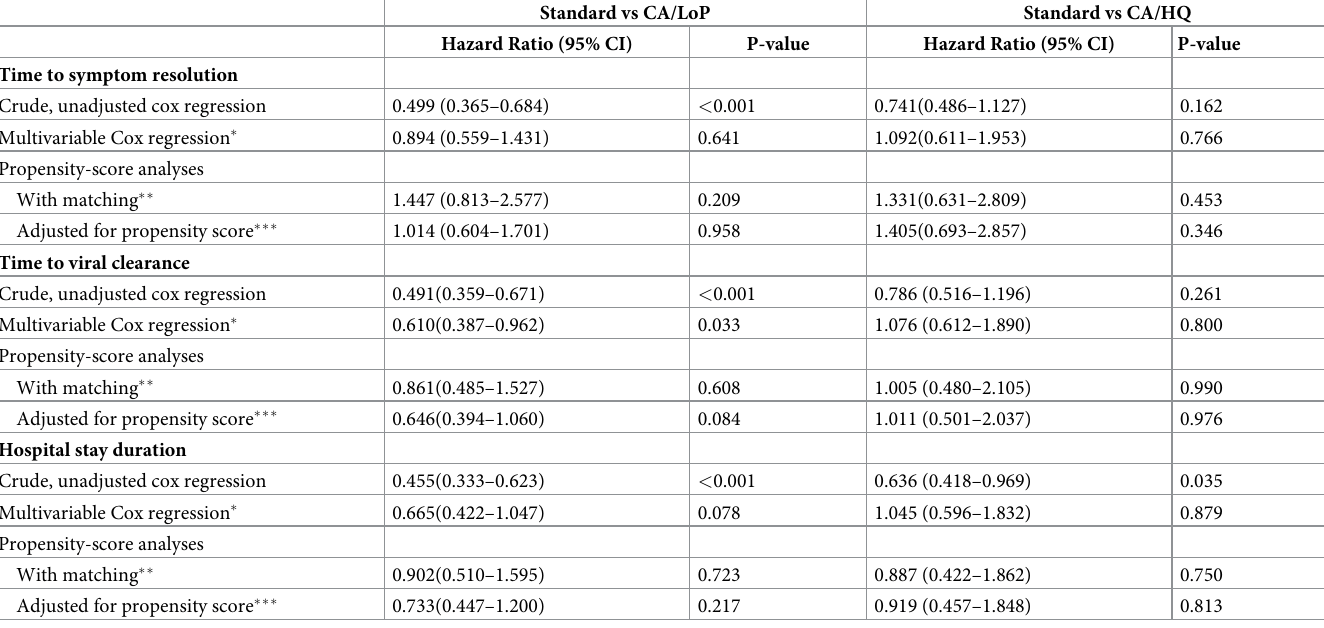
Table 5. Associations of antibiotics and antiviral treatments with time to symptom resolution, time to viral clearance, and hospital stay duration in crude analysis, multivariable analysis, and propensity score matching analysis. Standard therapy group is used as the